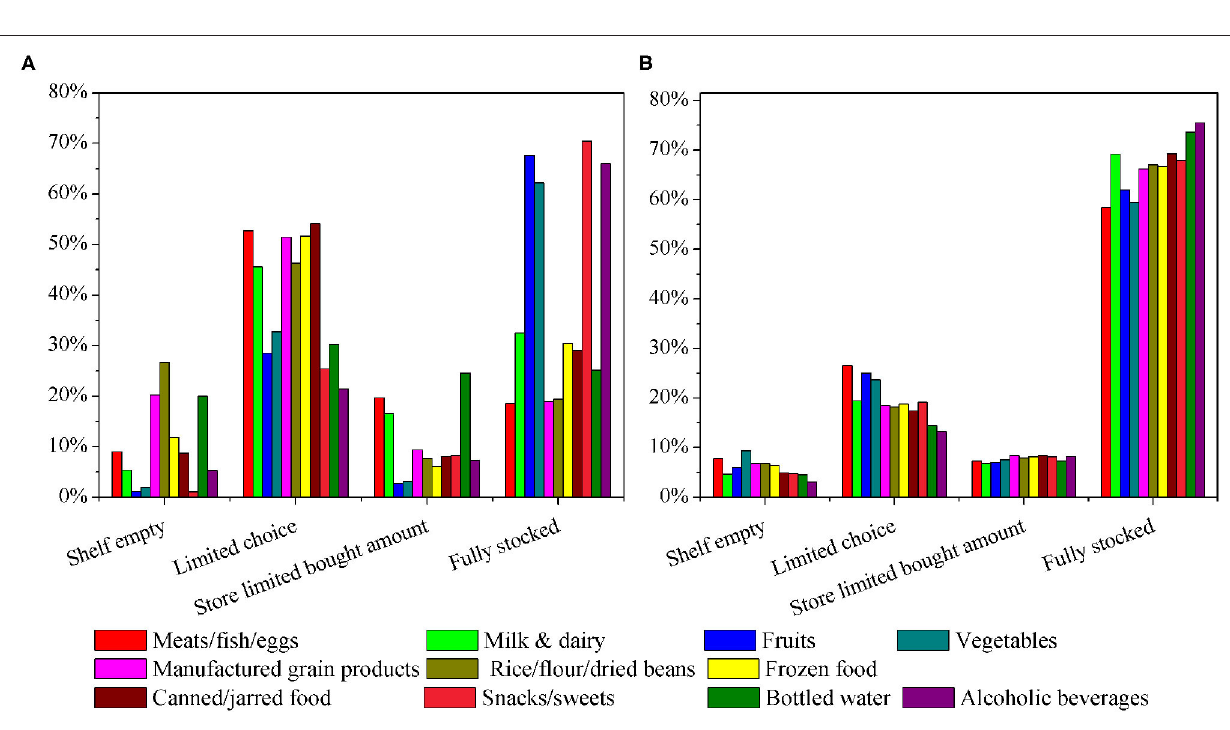
FIGURE 4 | Food availability as experienced when grocery-shopping by survey respondents from the U.S. (A) vs. China (B) . Foods were categorized into 9 groups. Two types of beverages were also included in survey questionnaire. Food availability was more variable for the U.S. than the Chinese datasets ( P <